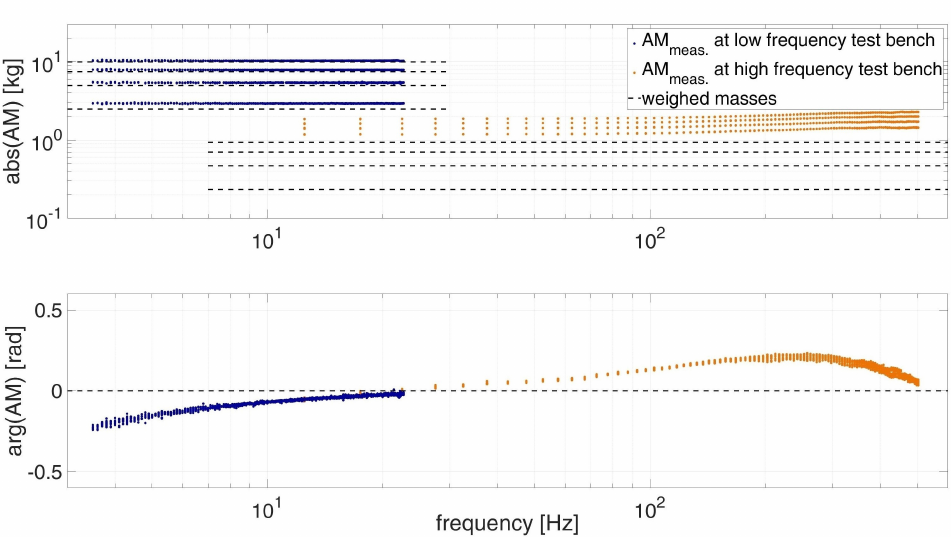
Figure 5. Apparent mass AM meas . of freely vibration masses over